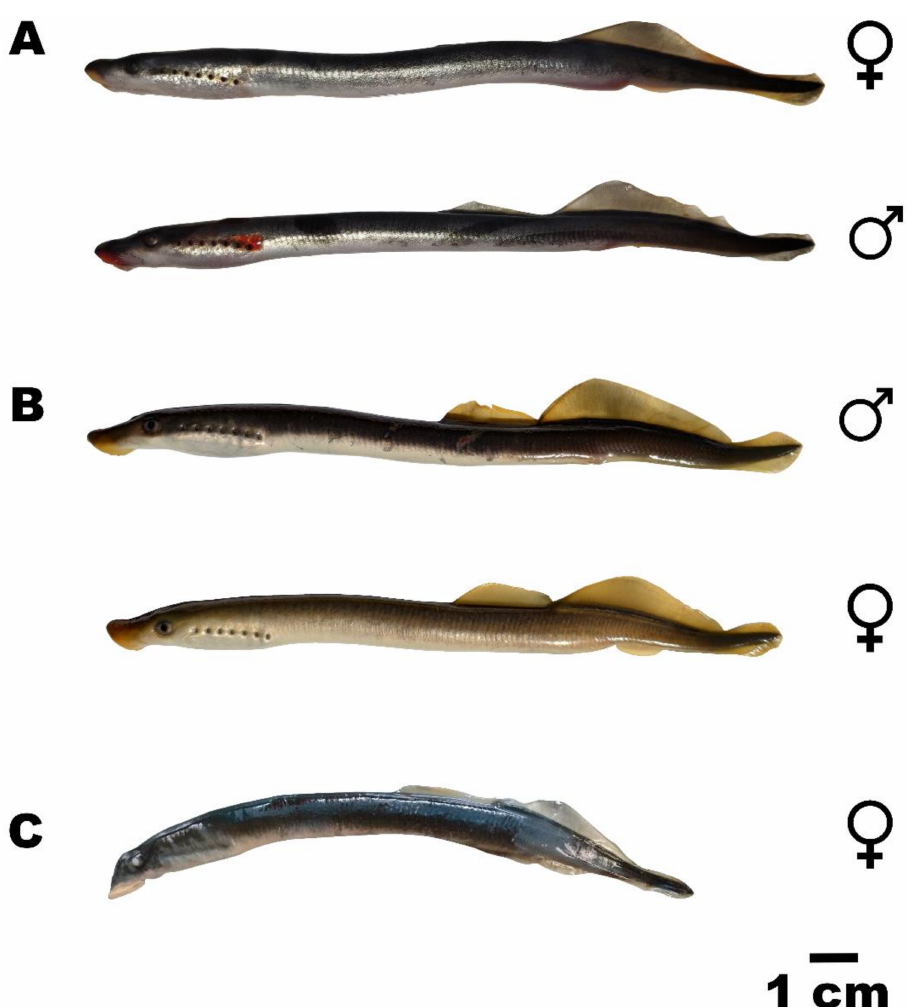
Figure 4. External appearance of mature adults of the European river lamprey, Lampetra fluviatilis, collected from the Vysochinsky Stream ( A ), Saragozha ( B ), and Kamenka ( C ) rivers in the spawn- ing